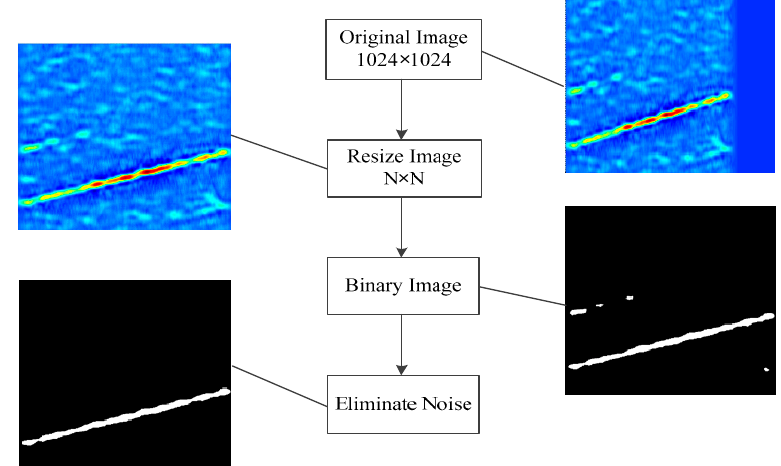
Figure 8. CWD image processing of P4 code at SNR of − 6 dB.